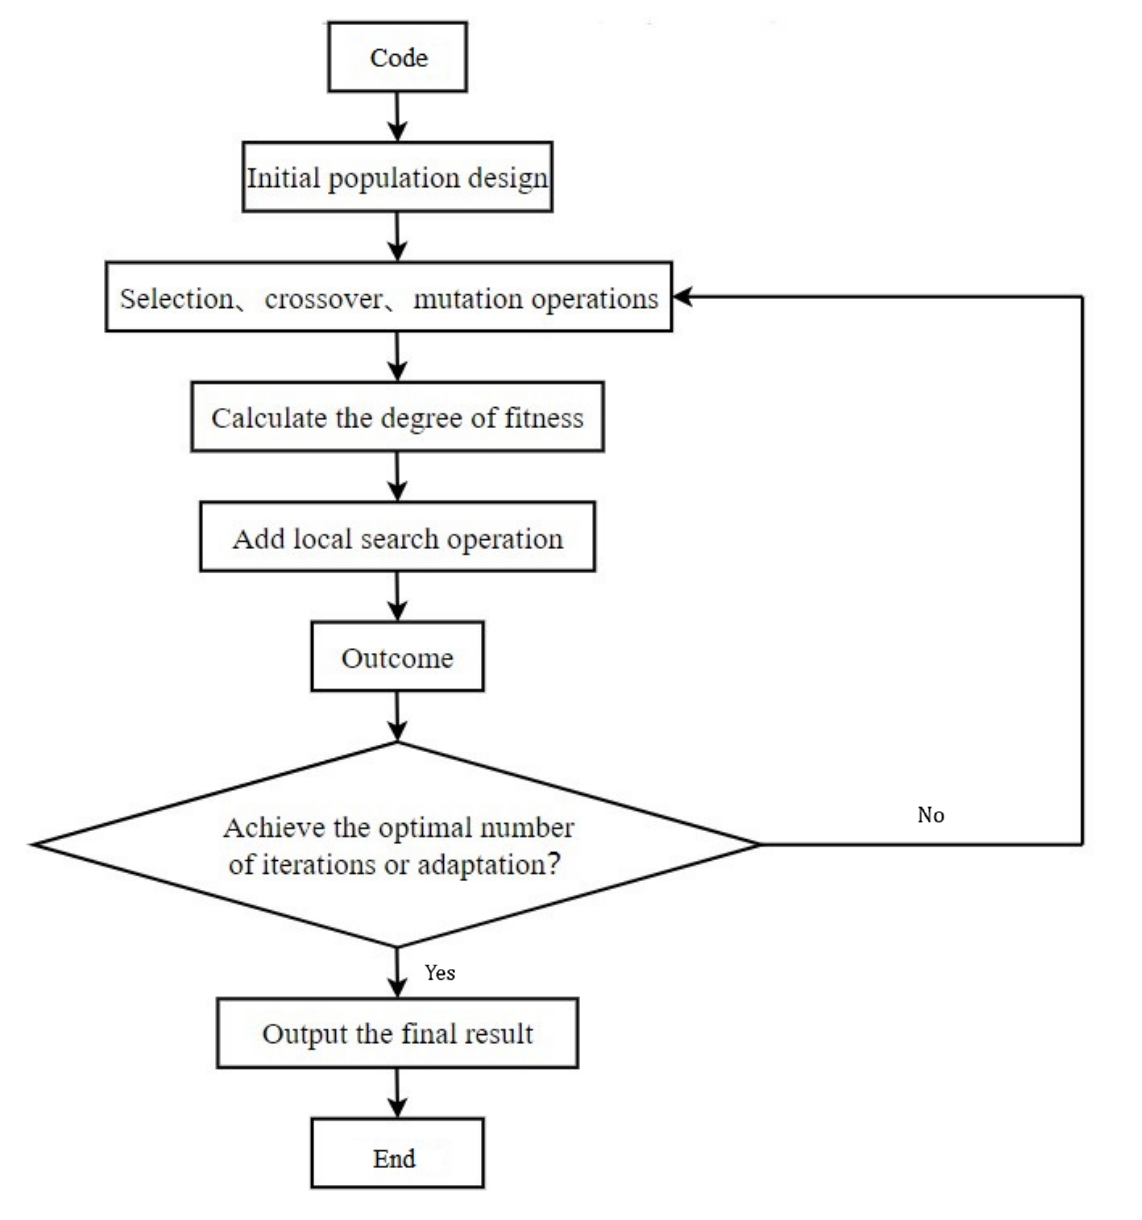
Figure 3. Improved algorithm procedure.